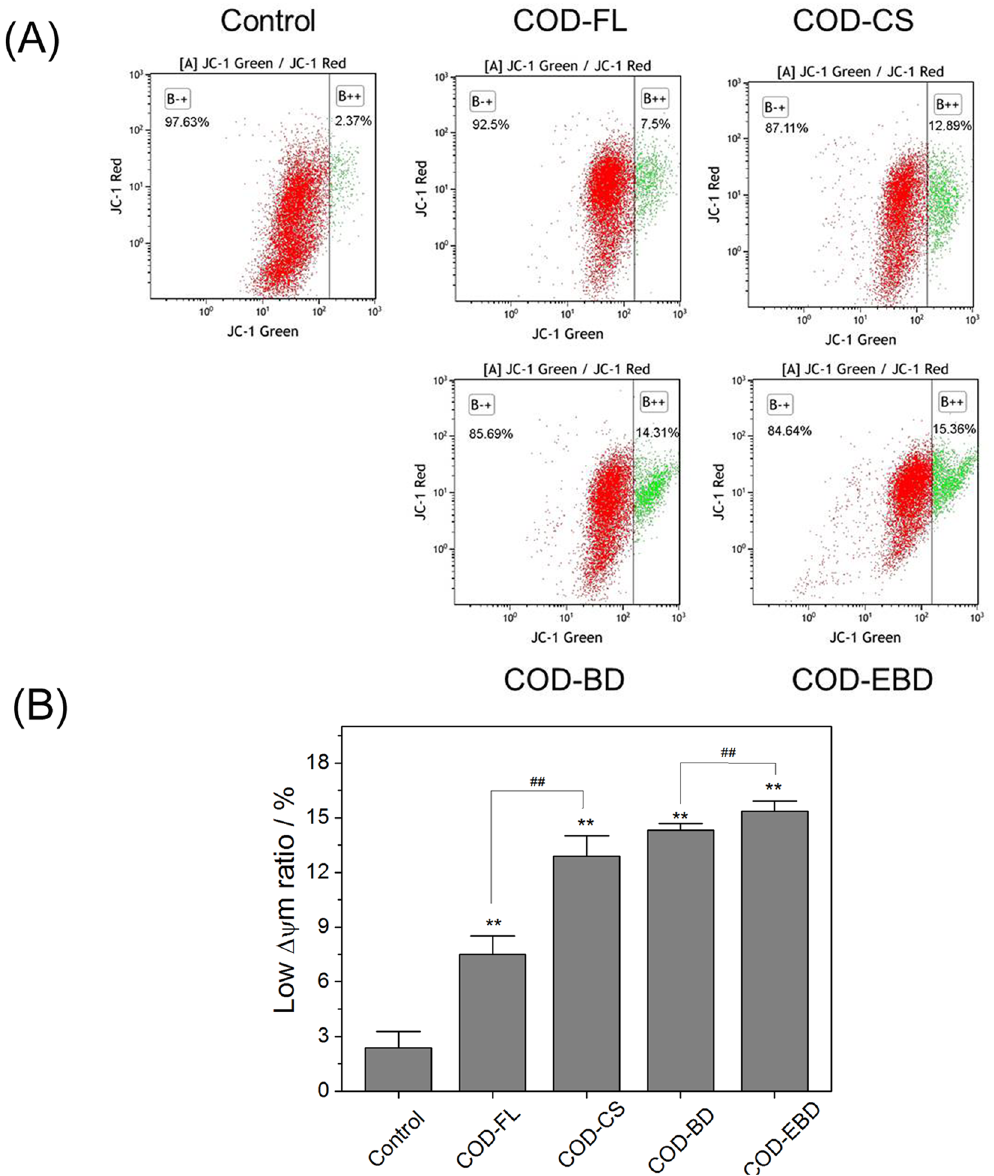
Figure 6. Effect of varying shapes of COD crystals on mitochondrial membrane potential ( Δ ψ m) in HK-2 cells. ( a ) Dot plot of Δ ψ m after incubation with varying shapes of COD crystals for 6 h; ( b ) quantitative histogram of Δ ψ m. Crystal concentration: 400 μ g/mL. Compared with control group, * p < 0.05. ** p < 0.01. COD-FL treatment group vs corresponding concentration of COD-CS treatment group, COD-BD treatment group vs corresponding concentration of COD-EBD treatment group, # P < 0.05, ## P <